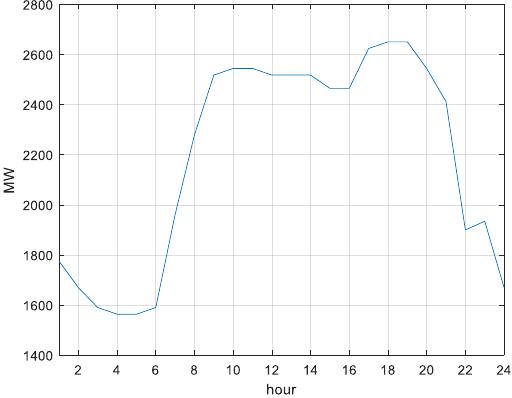
Figure 3. Load profile of the assisted system.